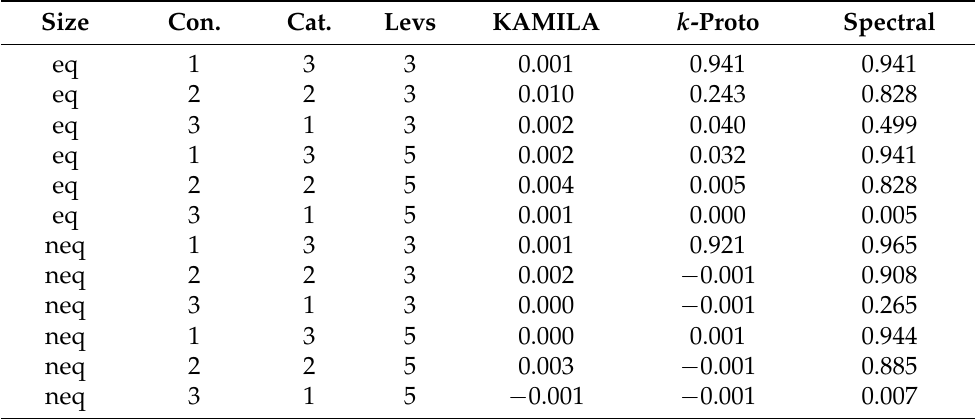
Table 4. Median ARI for high overlap in continuous variables and high overlap in categorical variables, n = 100 two-cluster data